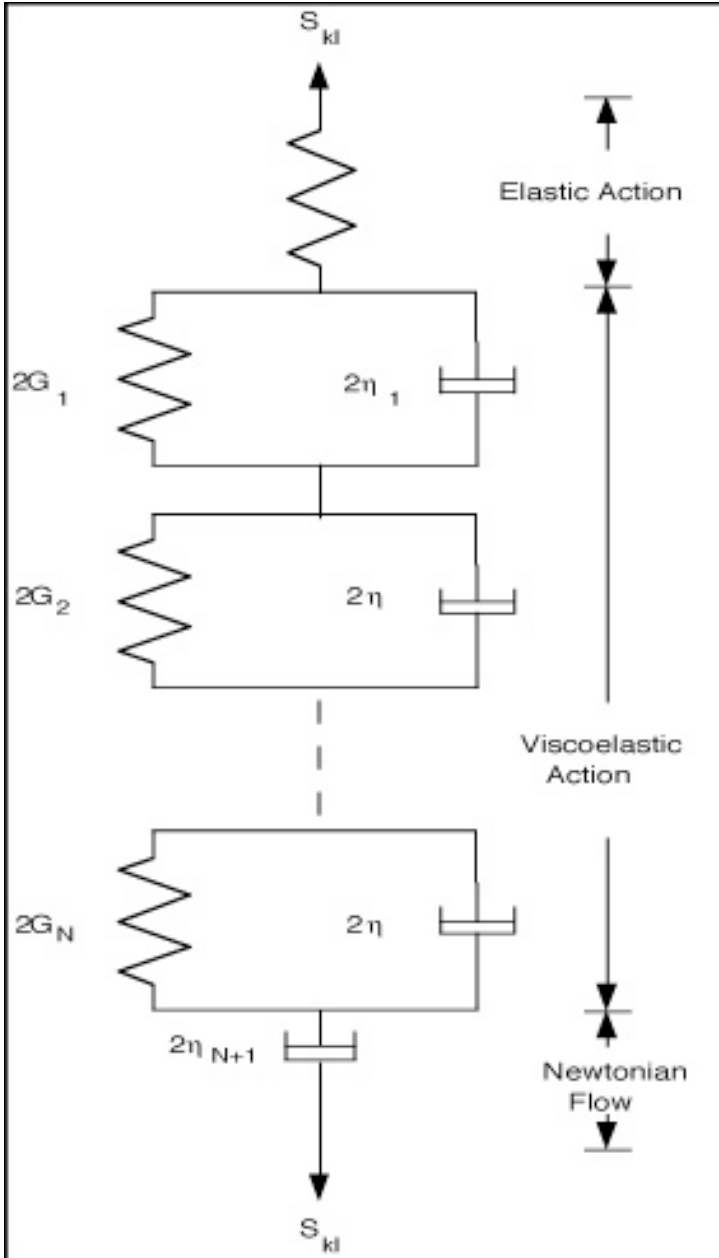
Figure 2. Generalized Kelvin